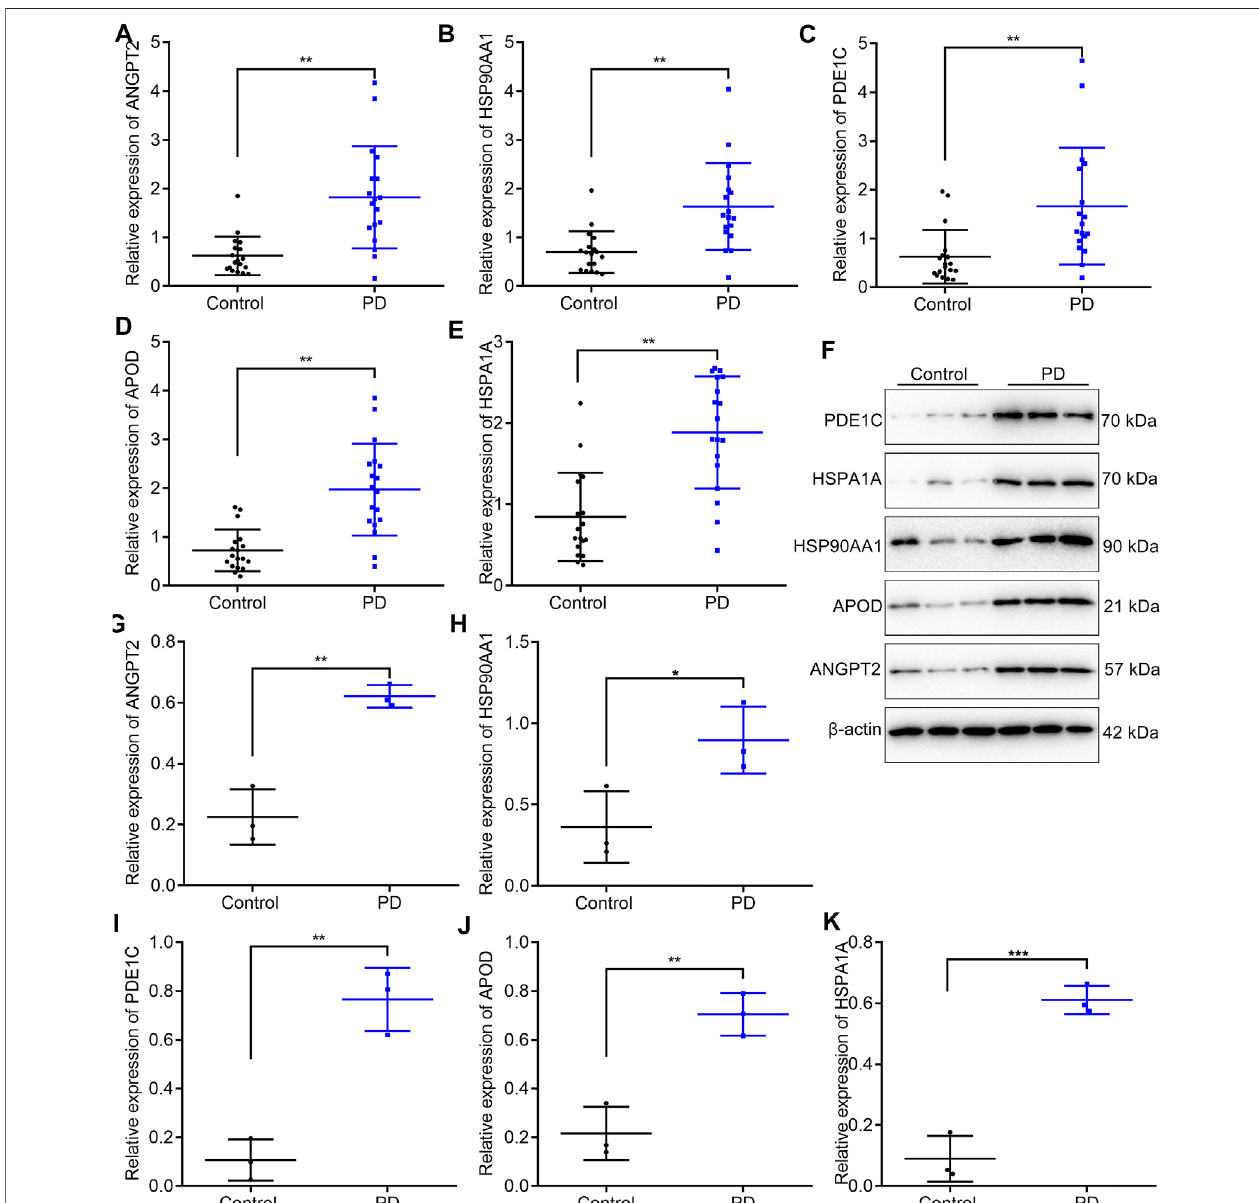
FIGURE 7 | Validation of the expression of fi ve upregulated marker genes in the cell – cell communication network in blood samples from PD patients and healthy participants. (A – E) RT-qPCR for detecting the mRNA expressions of ANGPT2 , HSP90AA1 , PDE1C , APOD , and HSPA1A in the blood specimens from 18 PD patients and 18 healthy participants. (F – K) Western blotting for measuring the protein expressions of ANGPT2, HSP90AA1, PDE1C, APOD, and HSPA1A in the blood specimens from 18 PD patients and 18 healthy participants. * p < 0.05; ** p < 0.01; and *** p <